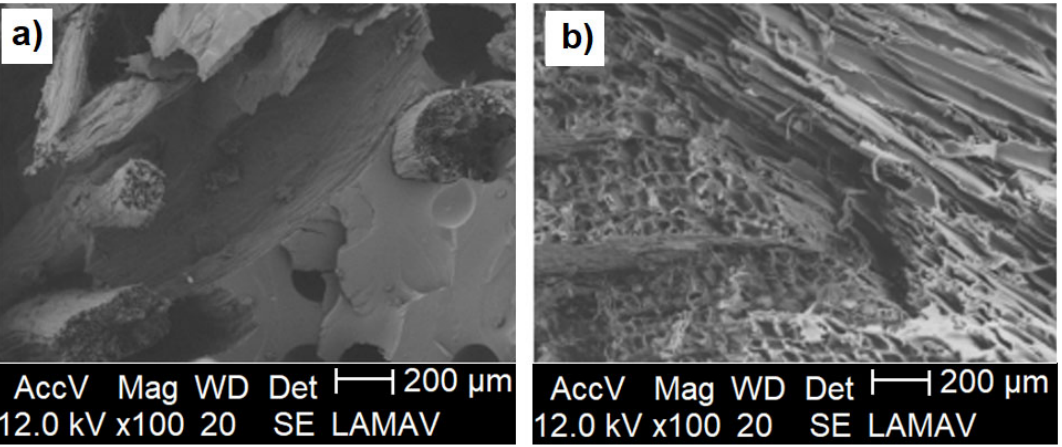
Figure 5. SEM photomicrography of the impact Charpy surface of fracture for the luffa reinforced COPU composite ( a ) and commercial OSB ( b ).